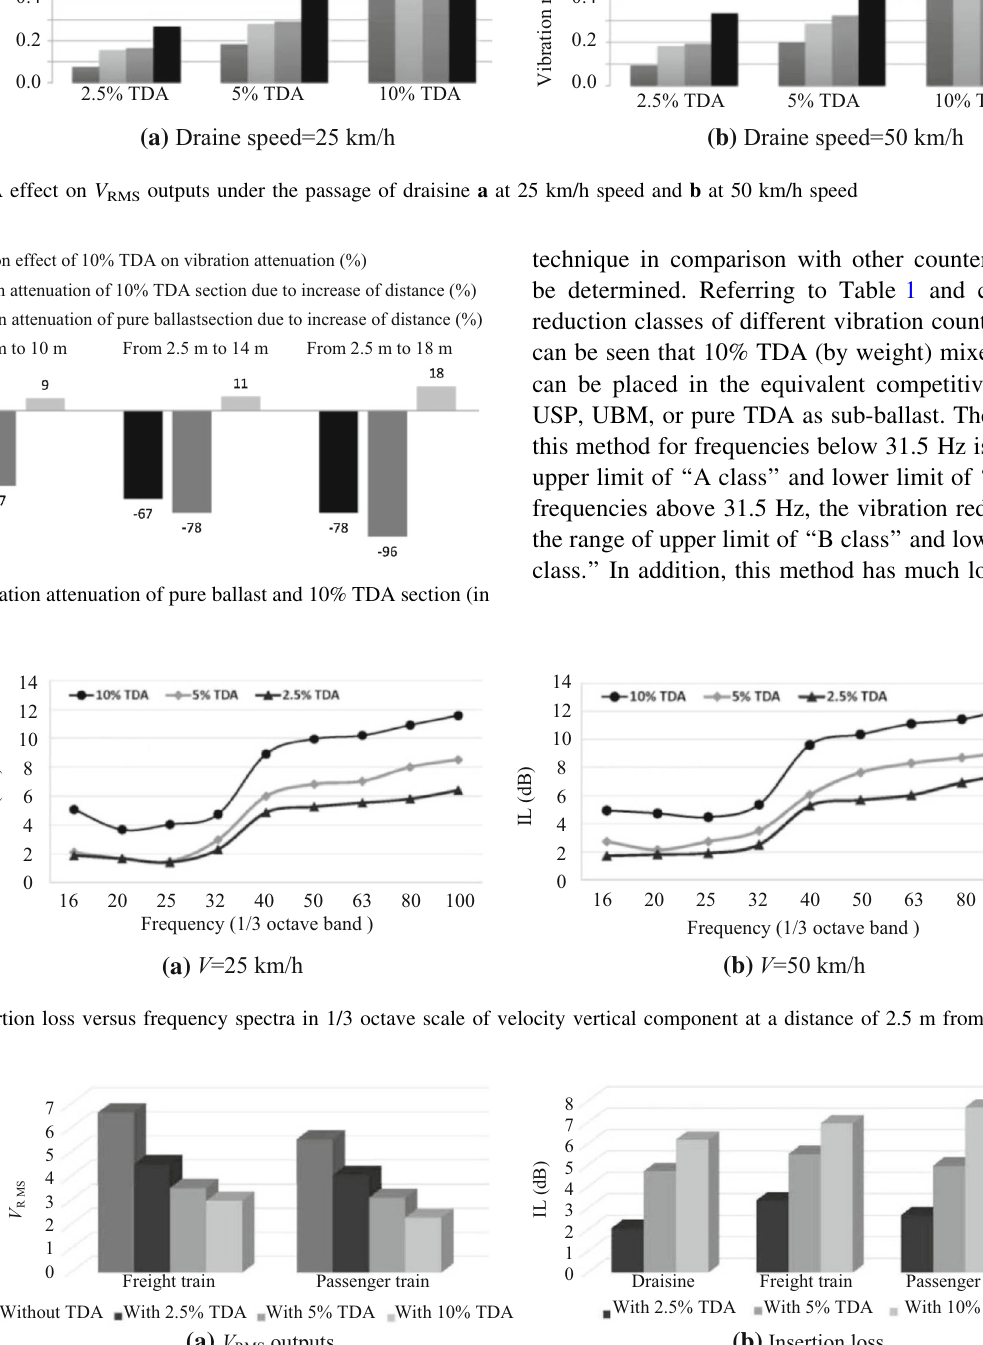
Freight train Passenger train0 Without TDA With 2.5% TDA With 5% TDA With 10% TDA